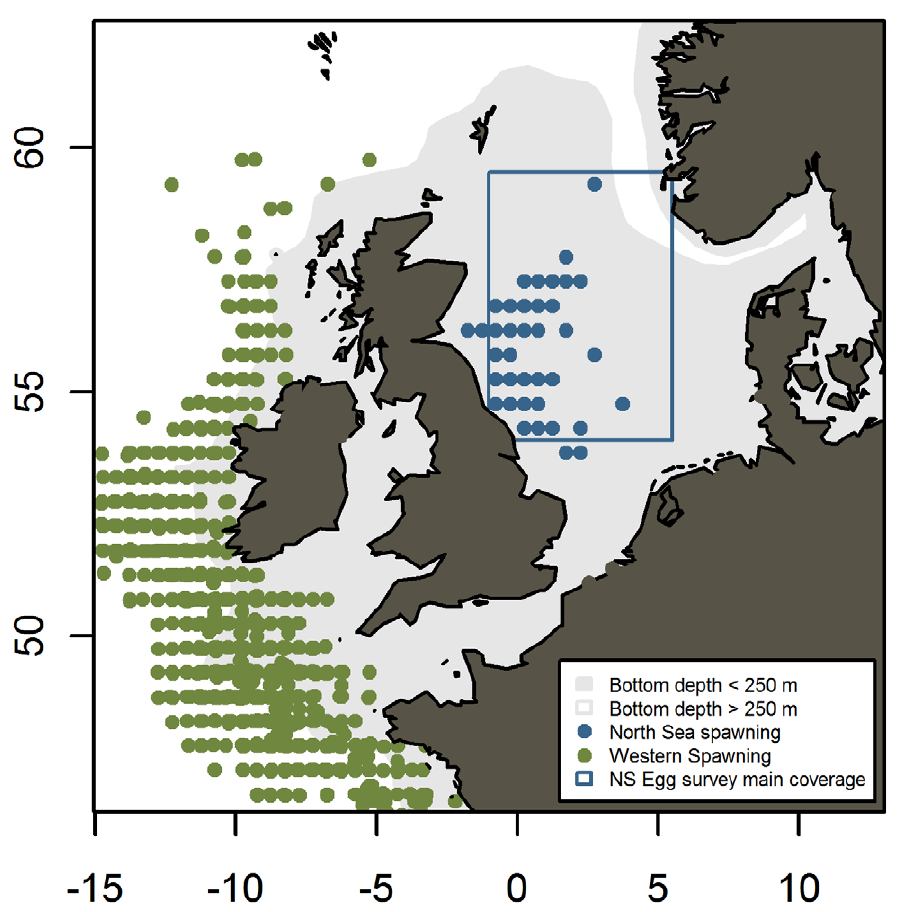
Figure 1. Mackerel populations and distribution around the north-western European shelf. Continental shelf marked in grey (bottom depth , 250 m). North Sea and western mackerel spawning areas indicated by dots. Each dot marks an observation of 50 + eggs m 2 2 day 2 1 . Data from international mackerel egg surveys (Blue=North Sea 2002–2011 [7,34,35], Green=Western areas 1977–2007 (ICES WGMEGS)). Blue rectangle marks the approximate main coverage of the international mackerel egg survey in the latter years [7,34,35].